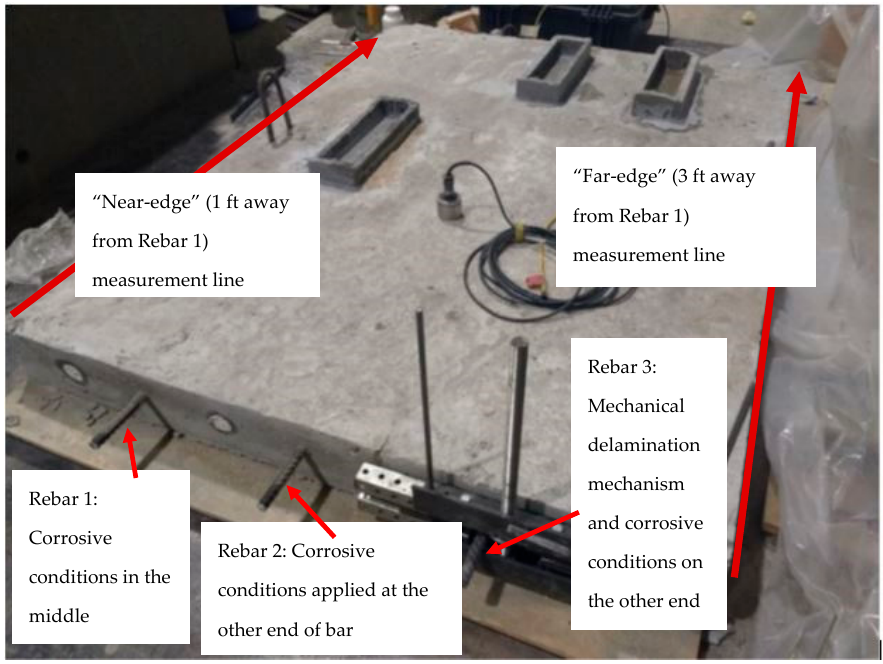
Figure 2. Specimen Set 1—the applied corrosion and delamination conditions.